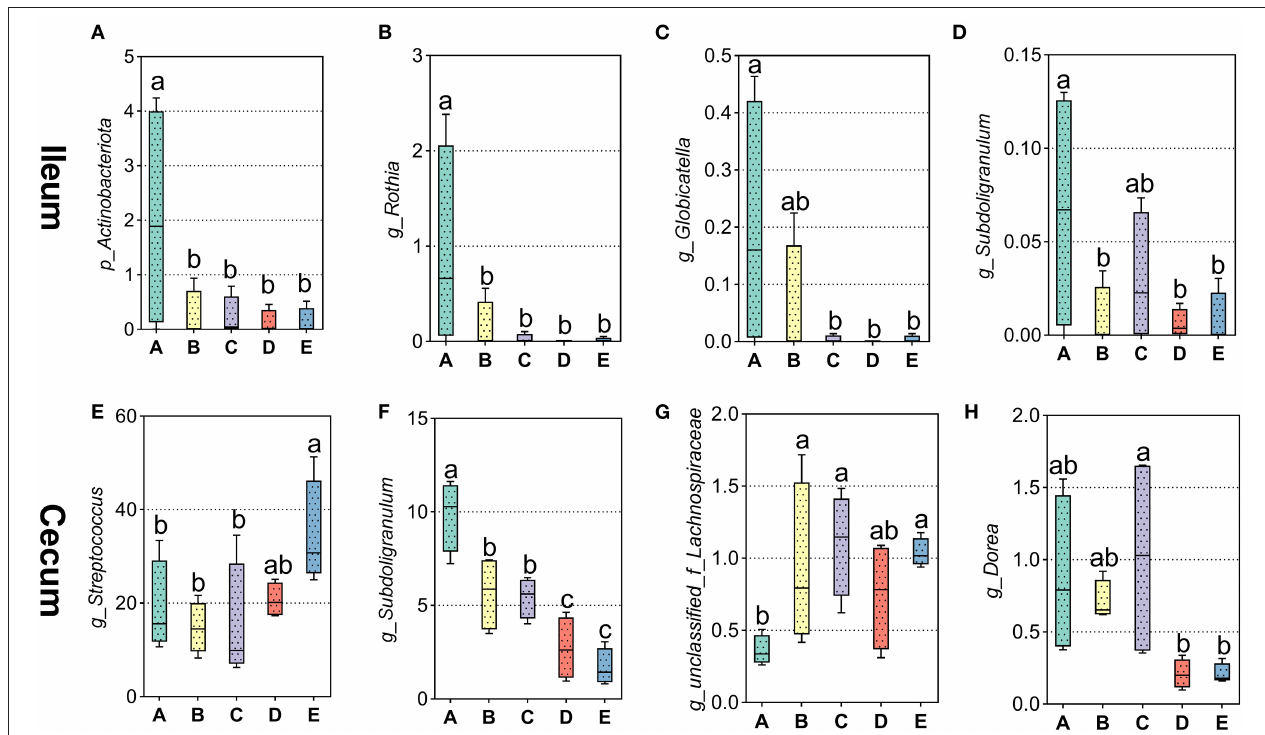
FIGURE 4 | Effects of different diets on different intestinal bacteria in weaned piglets. (A–D) Distribution of ileal different bacteria at phylum level and top 30 different bacteria at genus level in weaned piglets. (E–H) Distribution of cecal top 30 different bacteria at genus level in weaned piglets.